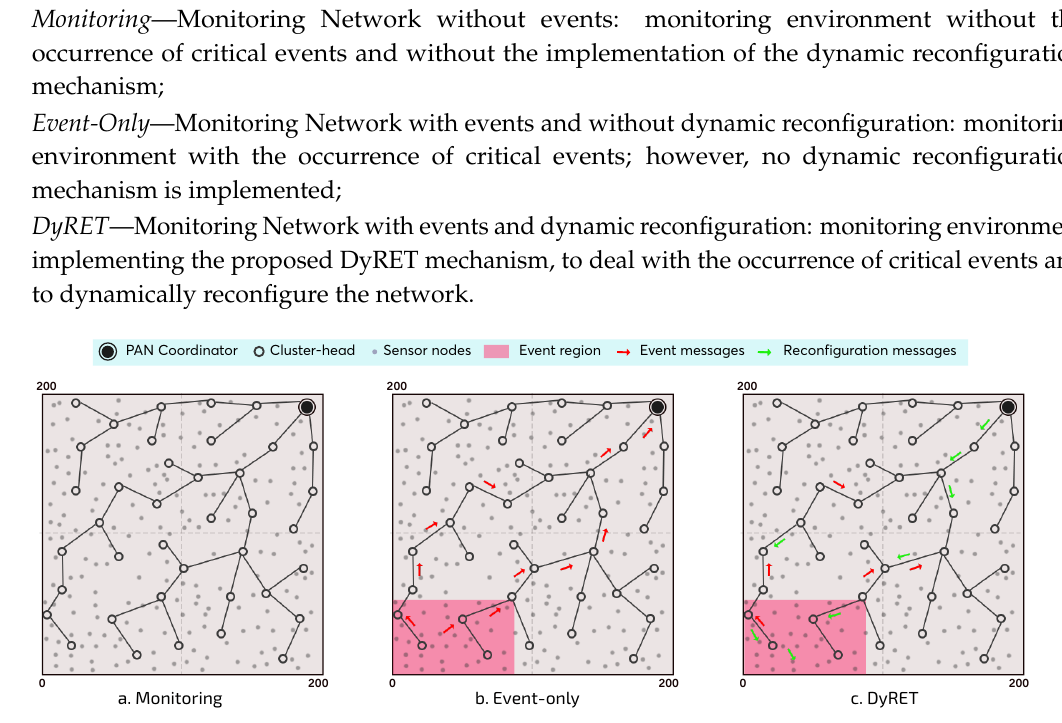
Figure 10. Different simulation approaches